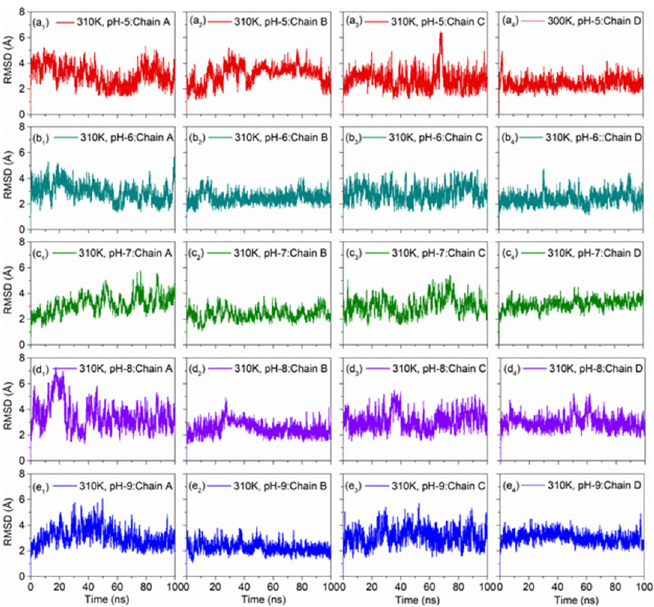
Fig 8. RMSD plots of the MD simulations of the DNA junction under 310K with altered pH, viz. (a 1 -a 4 ) pH5, (b 1 -